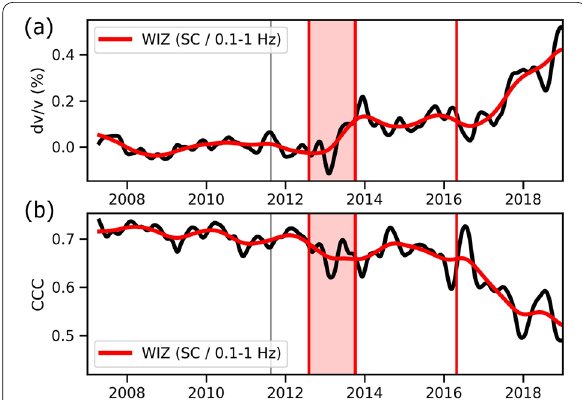
Fig. 5: 300-day moving-window correlation between lunar cycles and seismic amplitude. Faded colors correspond to measurements that are below the 5σ confidence level for correlation between the variables. Red symbols are for positive correlation and blue symbols are for negative correlation. See Fig. 4 for the description of the vertical lines corresponding to key time periods